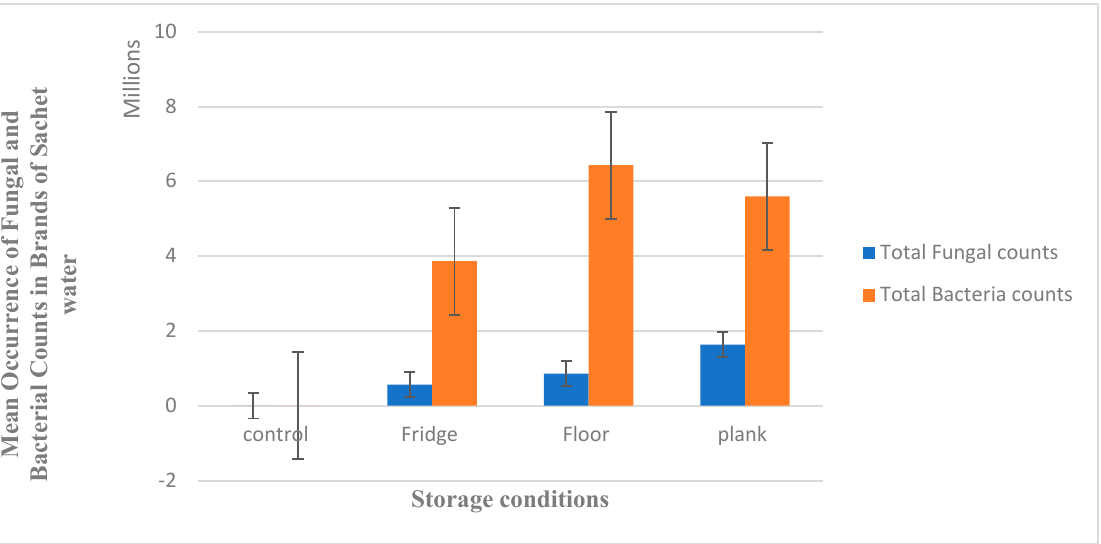
Figure 1. Bar chart diagram showing the occurrence of the total fungal and bacterial counts in the different storage conditions.